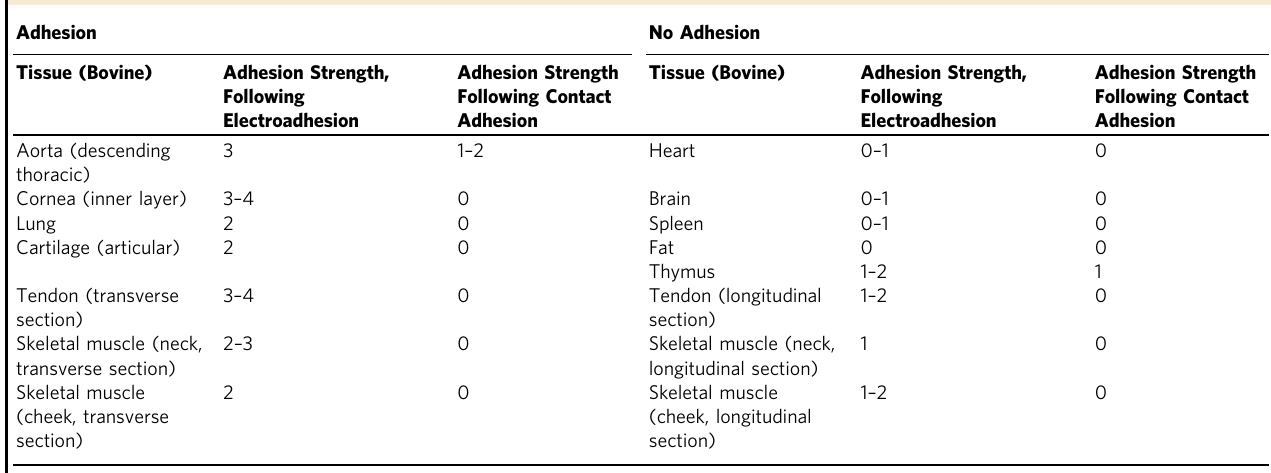
Table 1 Results of electroadhesion tests done with QDM gels and various bovine